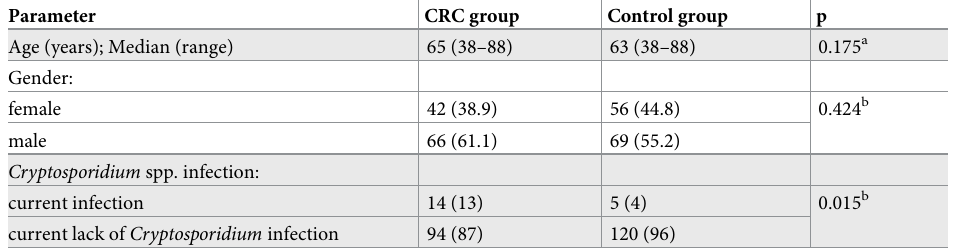
Table 2. Comparison of the characteristics and frequencies of Cryptosporidium spp. infections in colorectal cancer (CRC; n = 108) and control (n = 125)